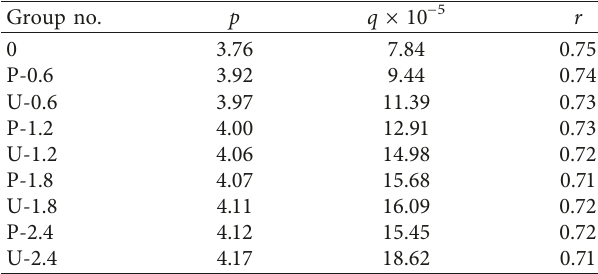
Table 7: Performance parameters of fiber concrete of different groups under different strain rates. Air Group pressure no. (MPa)